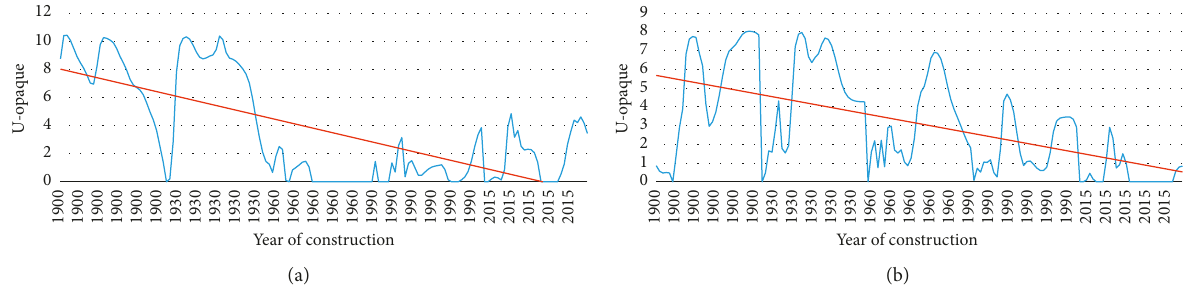
Figure 16: Sensitivity analysis results: U-opaque value versus year of construction. (a) Single-family buildings. (b) Block buildings.